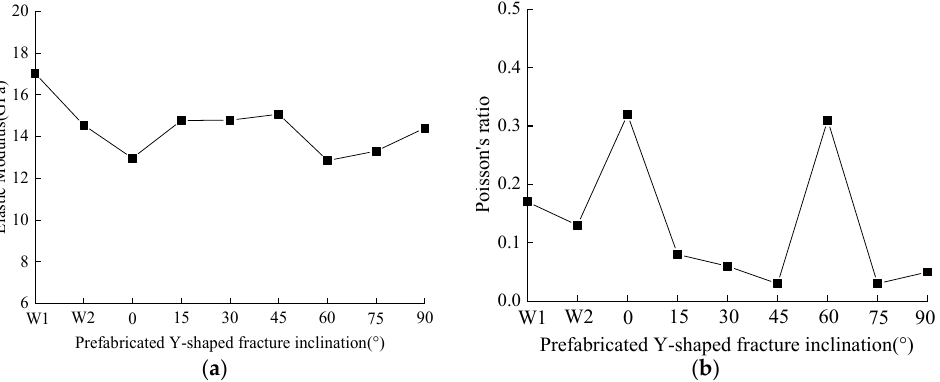
Figure 13. The relationship between the elastic modulus and the Poisson’s ratio of the intact and Y-shaped fracture samples: ( a ) relationship between the elastic modulus and the fracture inclination and ( b ) relationship between the Poisson’s ratio and the fracture inclination.